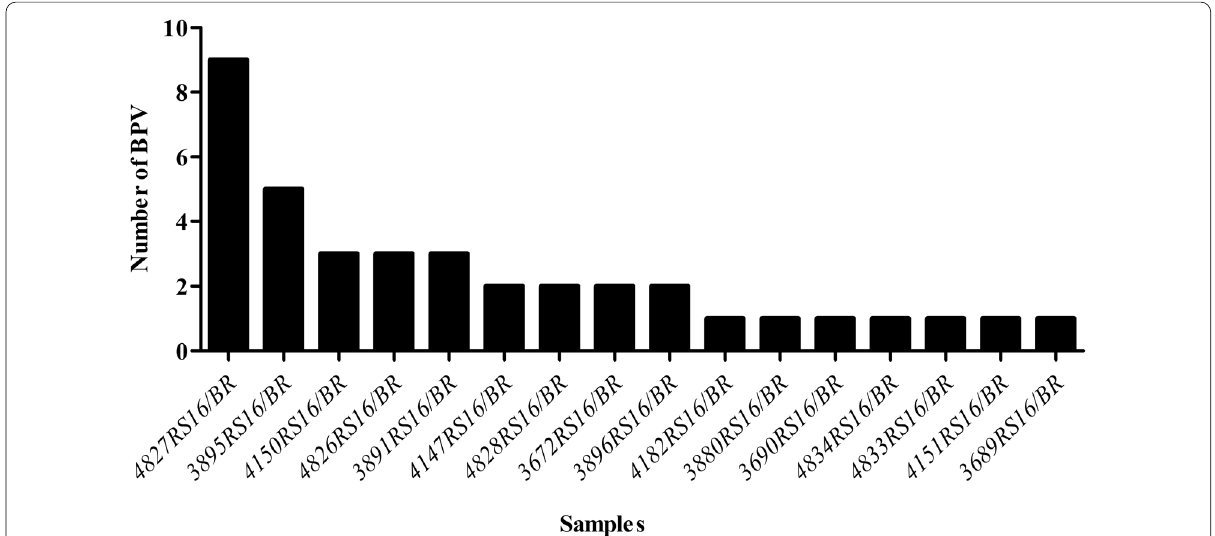
Fig. 1 Diversity of bovine papillomavirus (BPV) present in the samples of this study based on the presence of complete and partial (length > 350 bp) L1 gene sequences. BPV types, putative new BPV types and new BPV types described in this study were